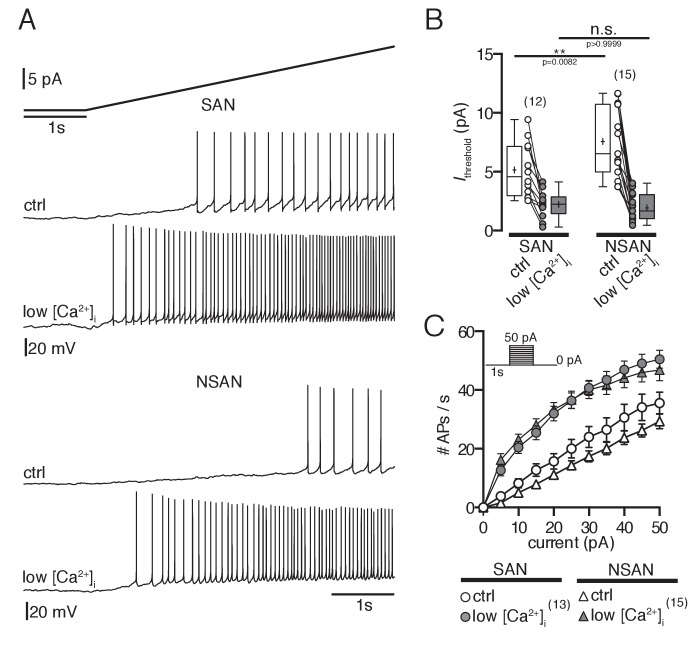
Low intracellular Ca2+ concentrations increase excitability in POMC neurons.(A and B) Spontaneously active neurons have a lower threshold current than silent neurons to elicit action potentials. Reducing [Ca2+]i decreased Ithreshold of silent and spontaneously active neurons to similar levels (ANOVA with Bonferroni analysis). (C) Number of action potentials during the current pulse as a function of injected current. Under control [Ca2+]i, the excitability is higher in spontaneously active neurons compared to silent POMC neurons (open symbols). Reducing [Ca2+]i increased the excitability of all neurons to similar levels. SAN, spontaneously active neuron; NSAN, not spontaneously active neuron (F < 0.5 Hz). *p<0.05.